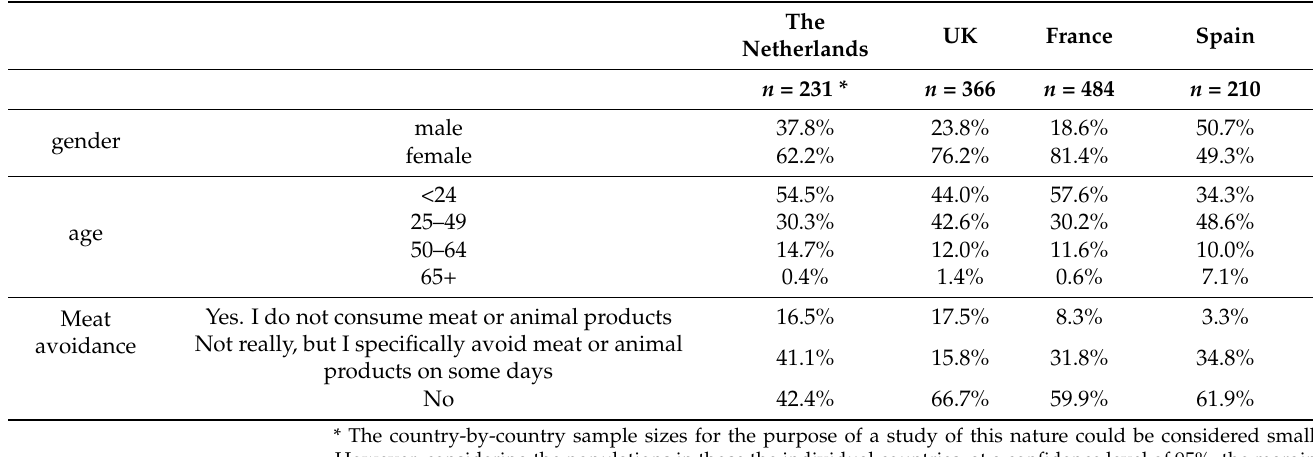
Table 1. Sociodemographics of the respondents in the four